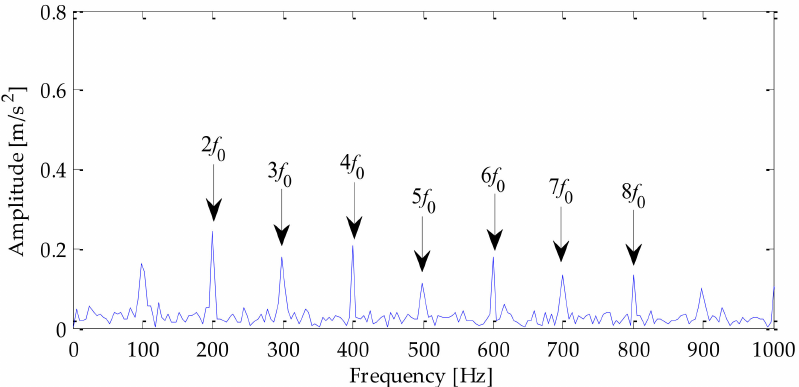
Figure 19. Analysis of signal envelope spectrum after noise reduction based on EEMD–RobustICA.